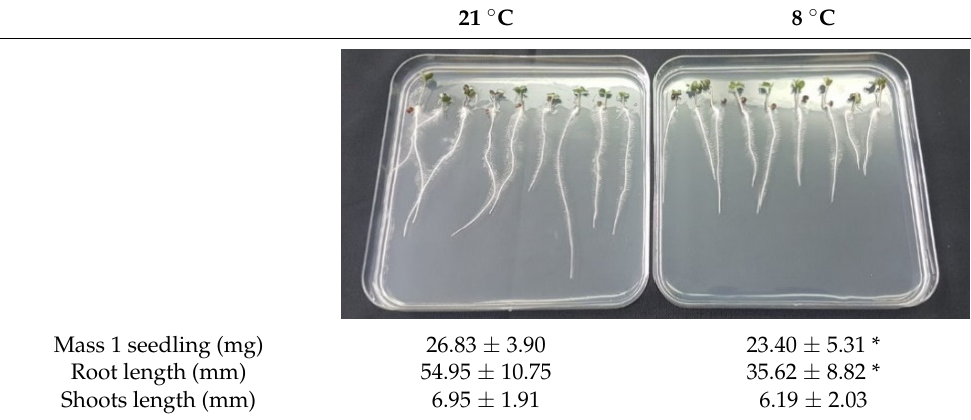
Mass 1 seedling